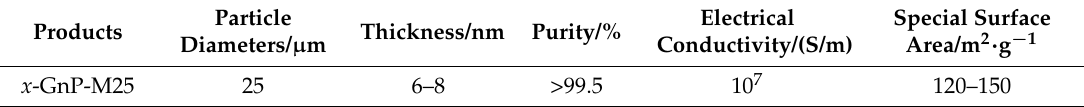
Table 5. Physical properties of GNPs.